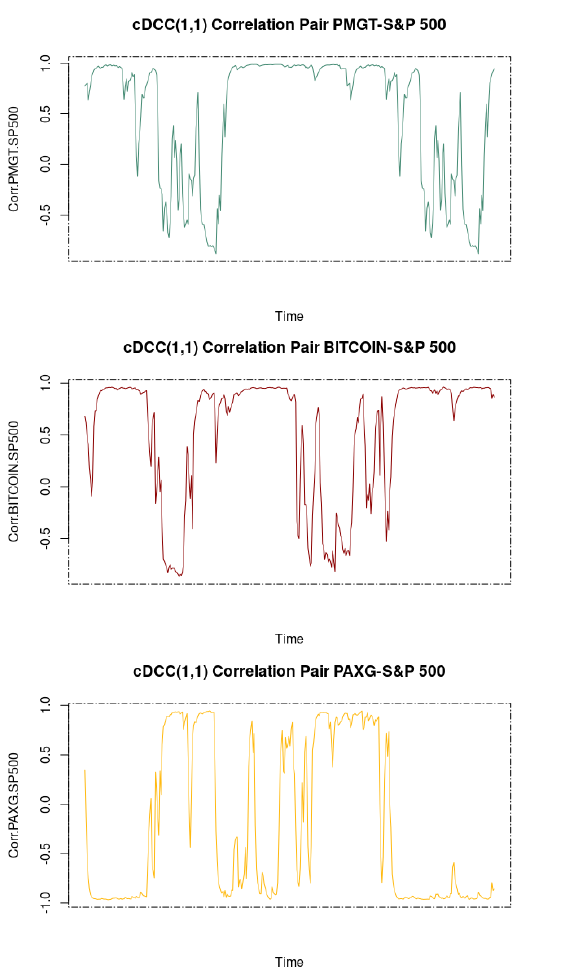
Figure 20. DCC correlations for safe-haven